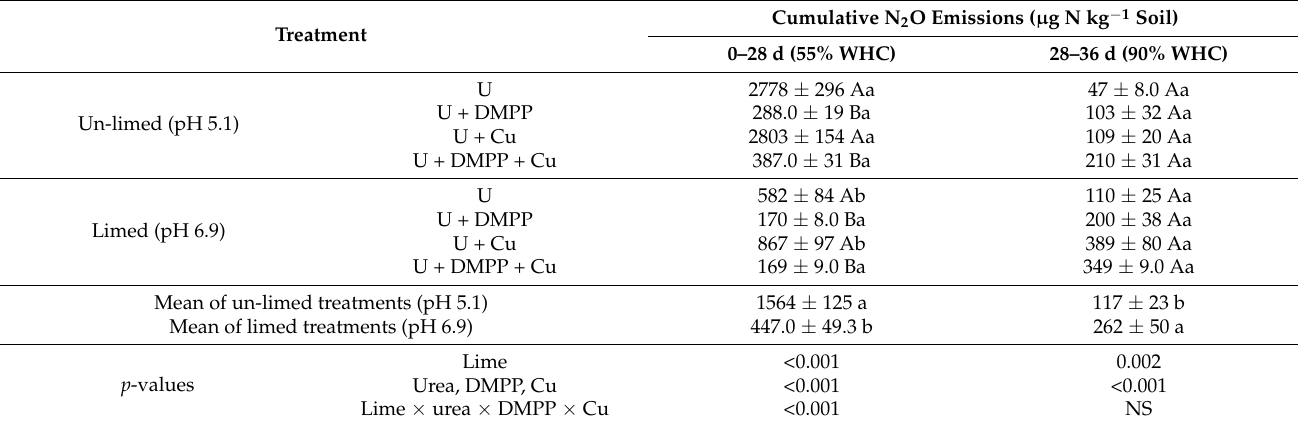
Table 2. Cumulative N 2 O emissions from the un-limed and limed sugarcane cropped soil. The soil water was maintained at 55% WHC for the first 28 d then increased to 90% WHC for the remainder of the experimental period. Data are the means of four replicates ±